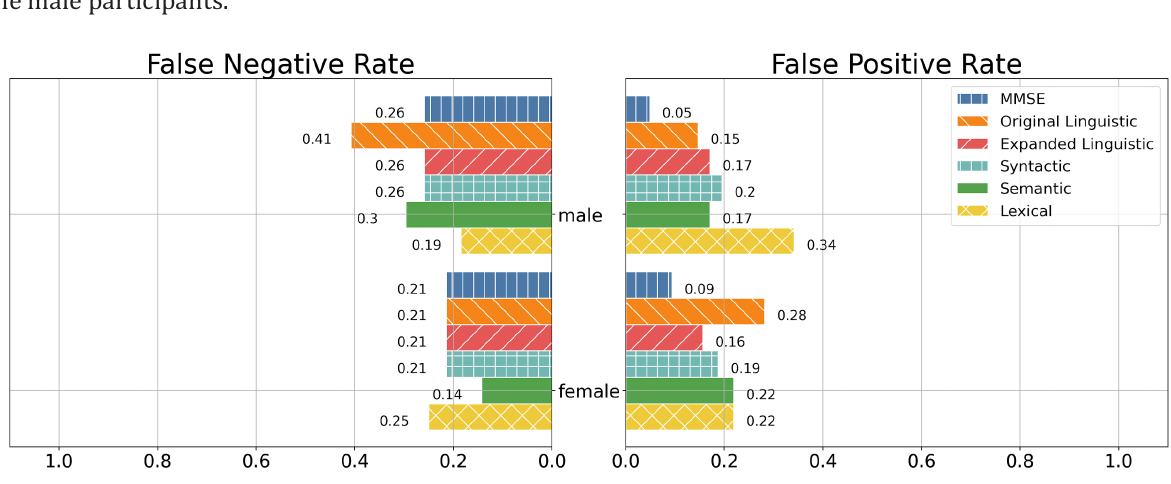
Figure 3. FNR and FPR of the MMSE, Linguistic, Syntactic, Semantic, and Lexical feature sets between males and females. Note: For interpretability, we only included the individual feature sets as well as the best-performing combination of feature